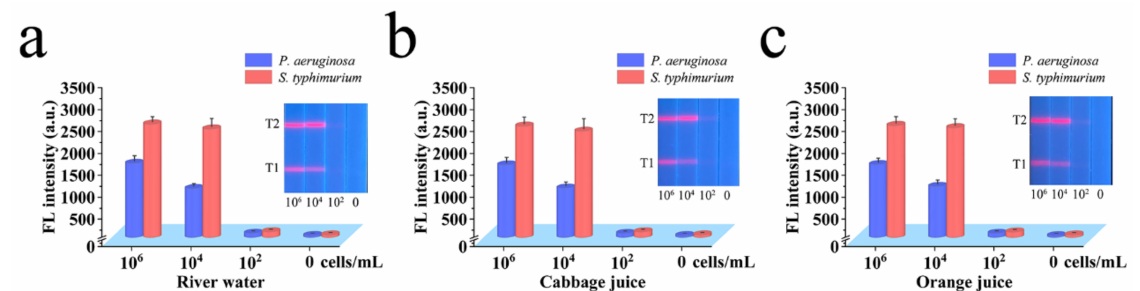
Figure 6. Performance of Mag@QDs-WGA-LFA in real samples including ( a ) river water, ( b ) cabbage juice, and ( c ) orange juice. The error bars indicate the standard deviations calculated from three separate experiments.